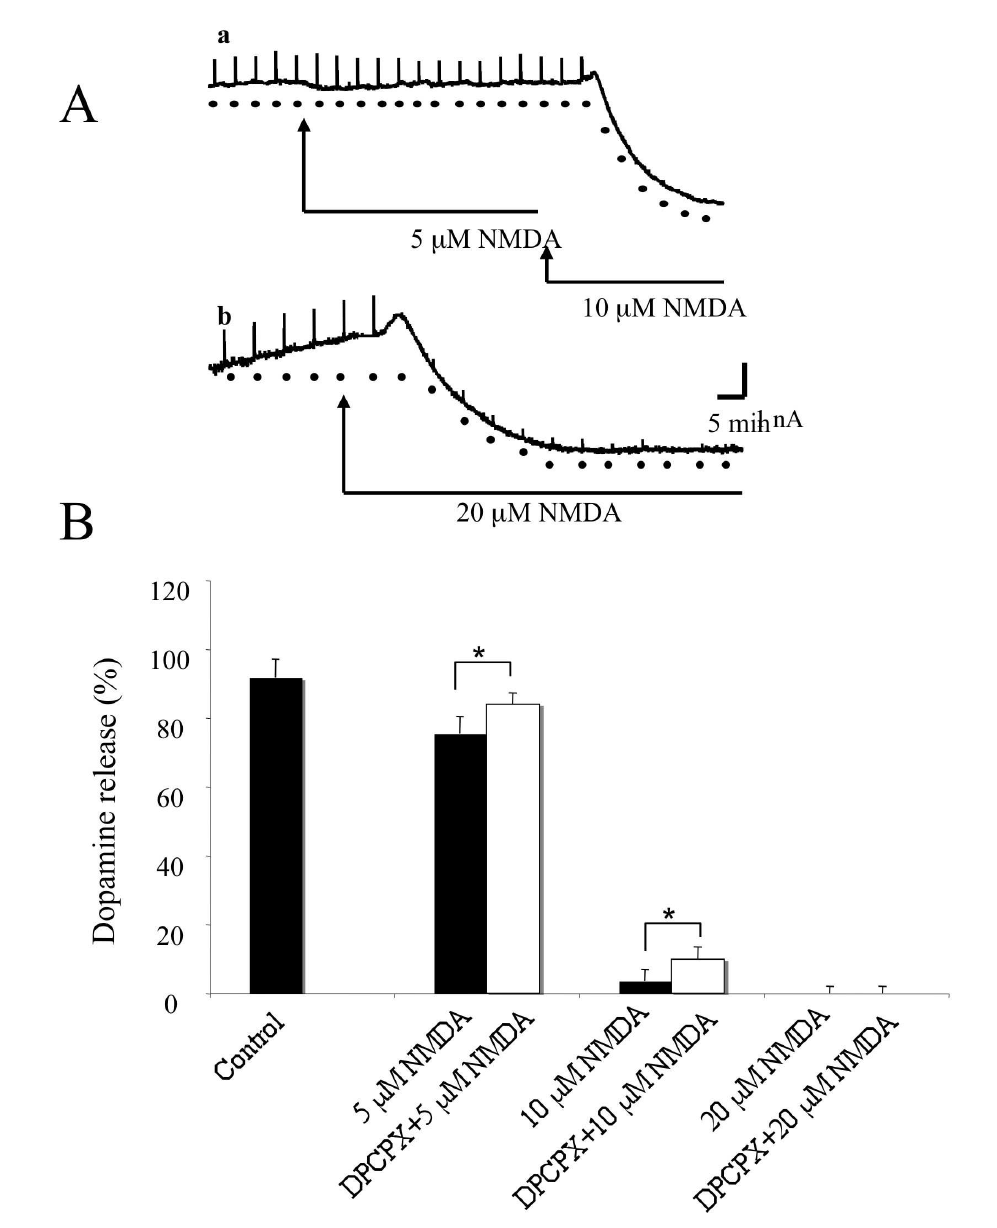
Figure 5. Effect of NMDA and DPCPX on single pulse evoked dopamine